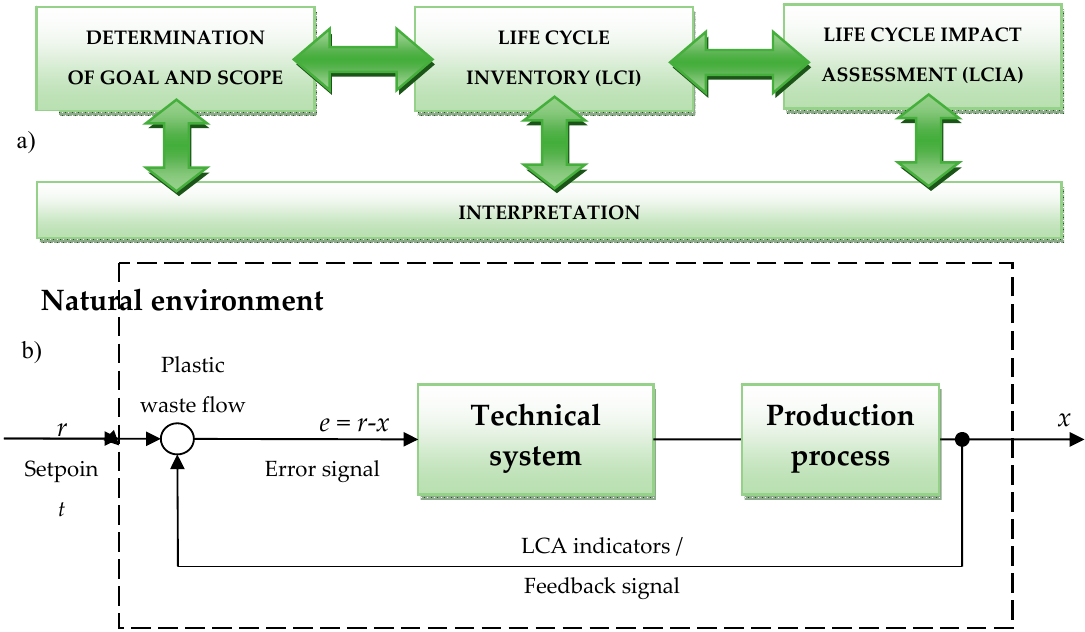
Figure 2. Stages of LCA analysis (in accordance with ISO 14044 ( a ) and flowchart of the closed arrangement of the environment and wind power plants energy system ( b ).